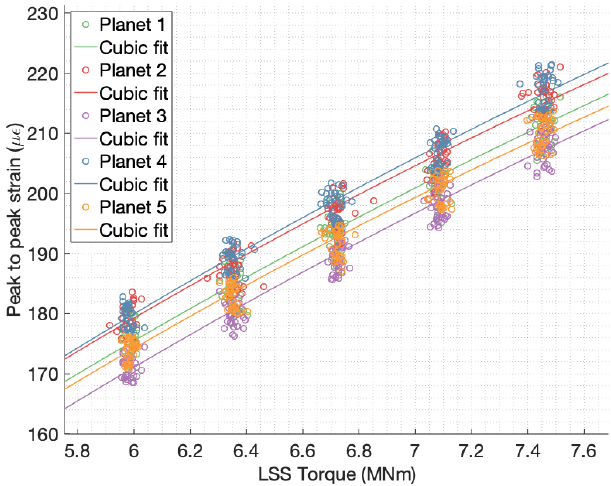
Figure 12. Peak-to-peak strain values of sensor S52 vs. torque in low-speed shaft separated for each planet (zoom for higher toque